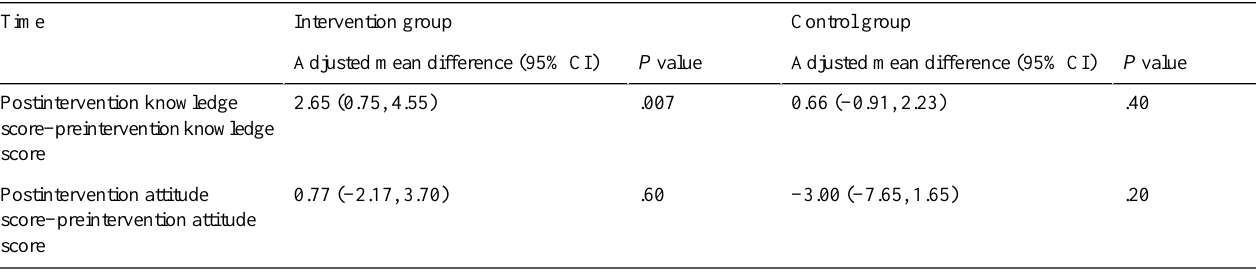
Table 2. Comparison of adjusted mean percentage scores of knowledge and attitude within the intervention and control group (n=50). a